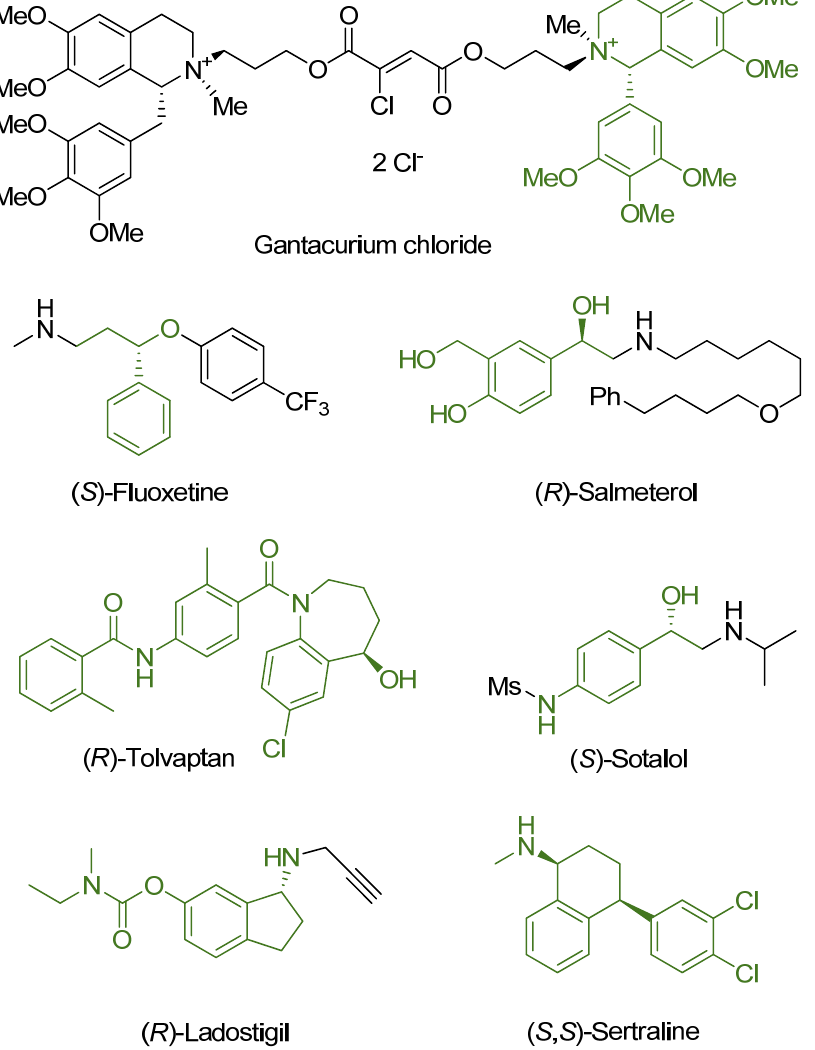
Figure 8. Examples of pharmaceutical products synthesized via ATH or AH using [RuCl( η 6 -arene)( N -arylsulfonyl-DPEN)] (the chiral building blocks obtained by these reactions are shown in